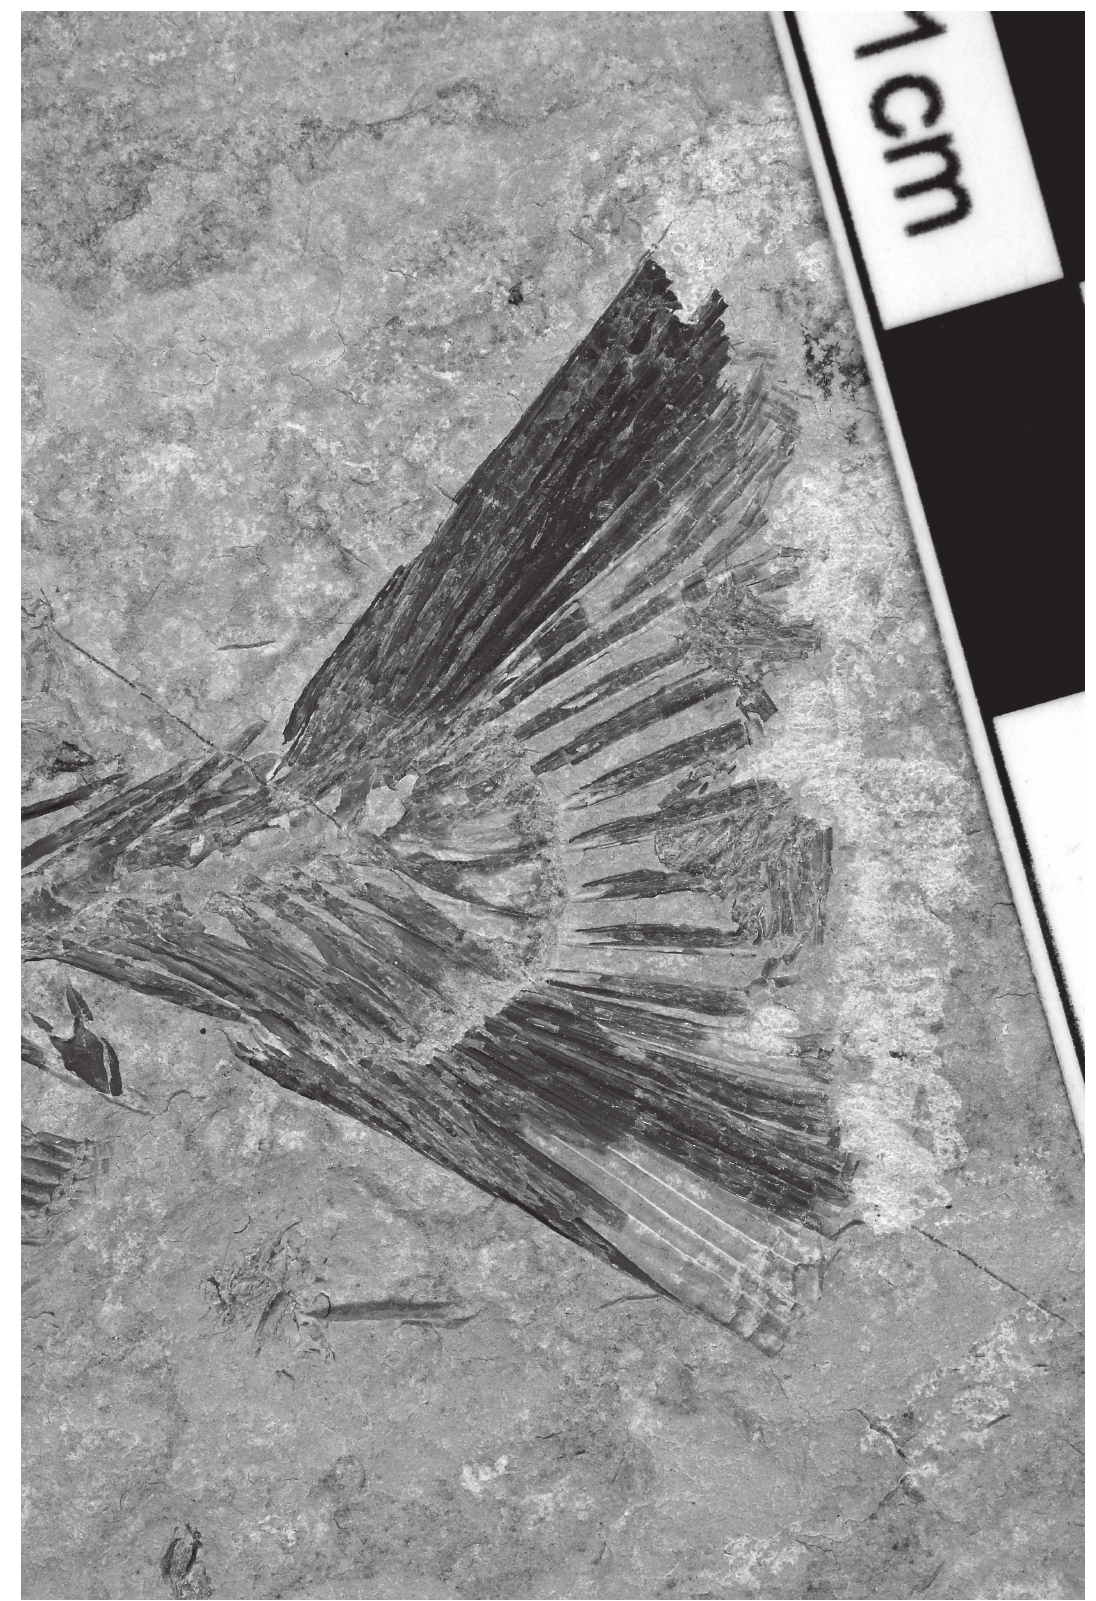
Fig. 15. Acrorhinichthys poyatoi gen. et sp. nov. Caudal region of paratype CLC